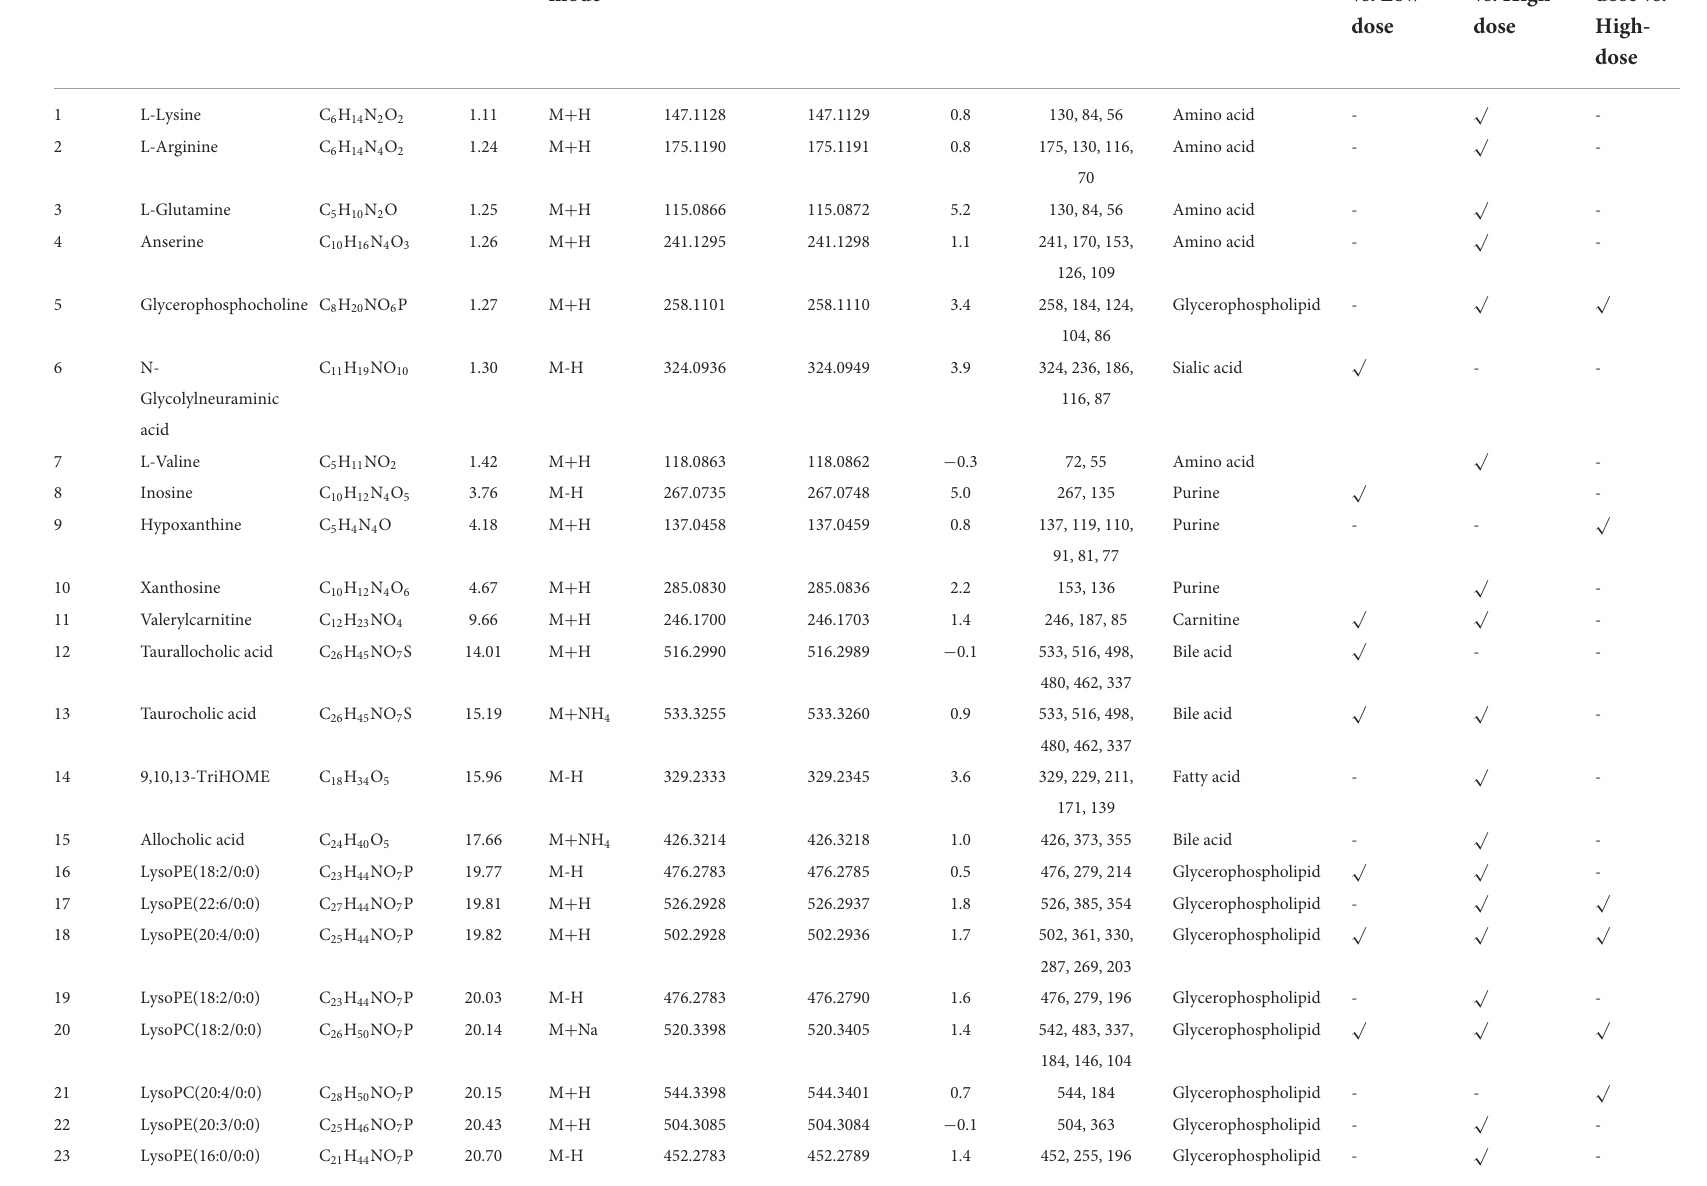
TABLE 4 Classification of differential